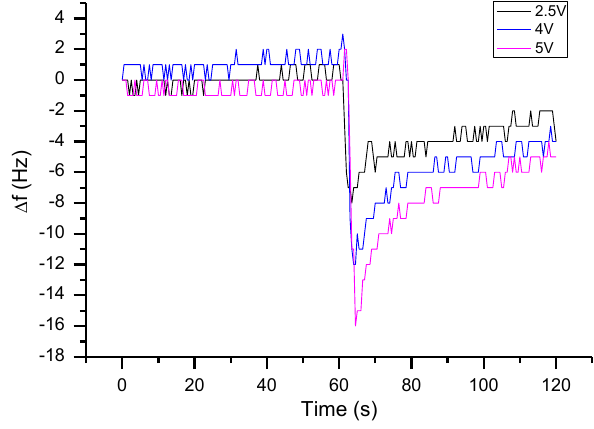
Figure 21. Frequency response of a 90° rotation with different supply voltages.